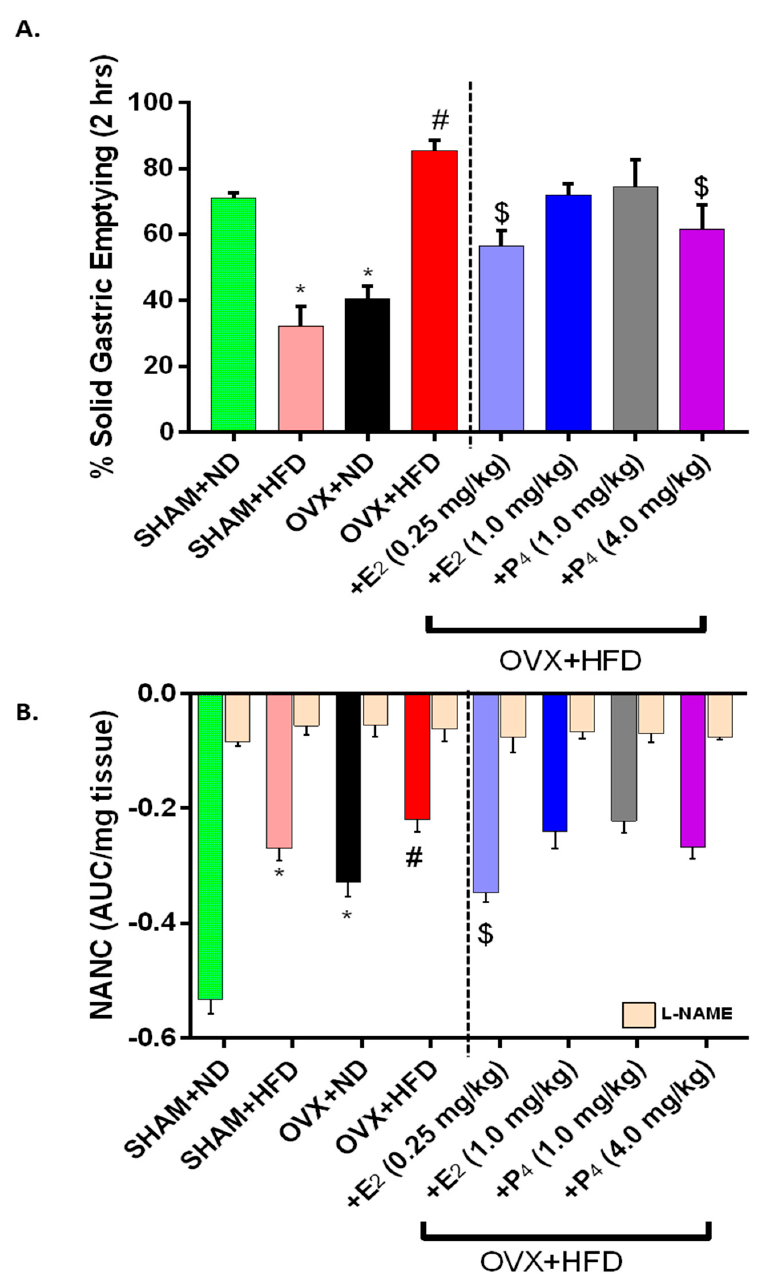
Figure 2. Effect of ovariectomy (OVX), 17 β -Estradiol (E 2 ), and Progesterone (P 4 ) on ( A , B ) 2 h solid gastric emptying and gastric antrum nitrergic relaxation in HFD fed mice. Full and empty stomach weights were recorded; the difference estimated the remaining gastric content (GC) after 2 h of fasting. The rate of gastric emptying (GE) was measured with the equation of 1- [(Gastric Content /Food Intake) × 100. Nitrergic relaxation was measured in gastric antrum circular muscle strips at 2 Hz in an organ bath under physiological conditions. The nitric oxide (NO) dependence of the non-adrenergic non-cholinergic relaxation (NANC) relaxations was confirmed by preincubation (30 min) with the NO inhibitor nitro-L-arginine methyl ester (L-NAME; 100 μ M). Area under the curve for is presented. Data were analyzed using one-way ANOVA by using graph pad prism software. Data are means ± SEM ( n = 6). * p < 0.05, significantly different from normal diet-fed sham-operated (SHAM+ND) mice. # p < 0.05, significantly different from normal diet-fed ovariectomized (OVX+ND) mice. $ p < 0.05, significantly different from high-fat diet-fed OVX (OVX+HFD) mice.